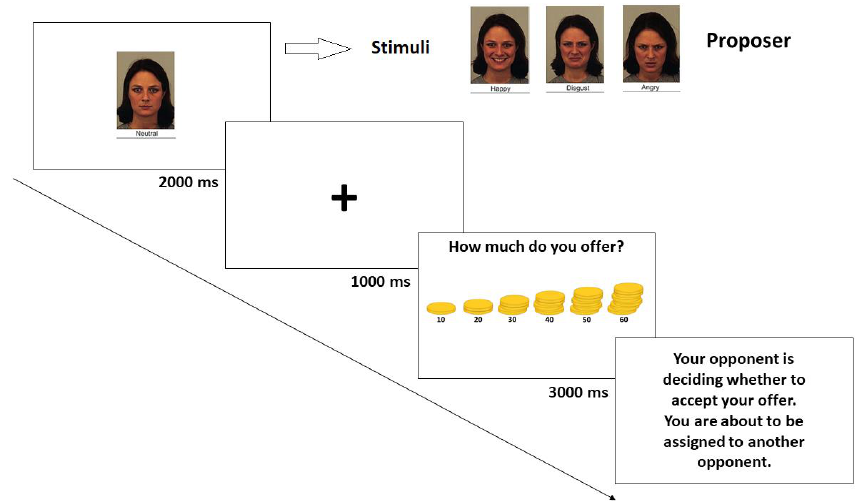
Figure 4. Task timeline for the ultimatum game in the p roposer’s experiment.